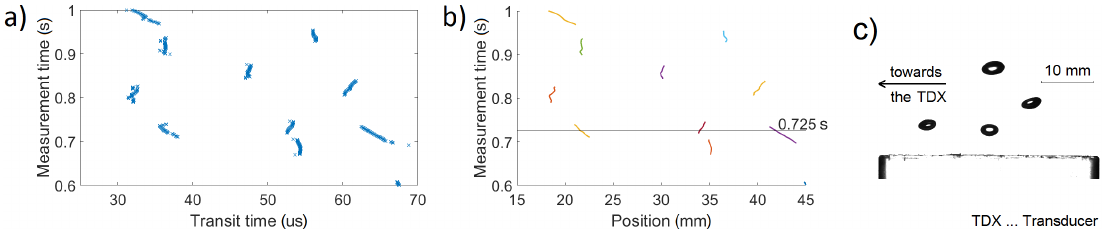
T ≈ 53 µ s). ( b ) The reference signal. ( c ) An example of the cross-correlation function calculated from